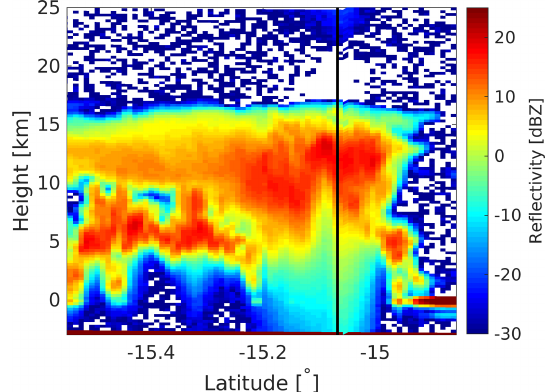
Figure 5. Example of second-trip echoes, visible between 22 and 25km, generated by MS tails in CloudSat reflectivity vertical profile observations of a deep convective system. The satellite is moving southward from Indonesia towards Australia over the Indian Ocean.